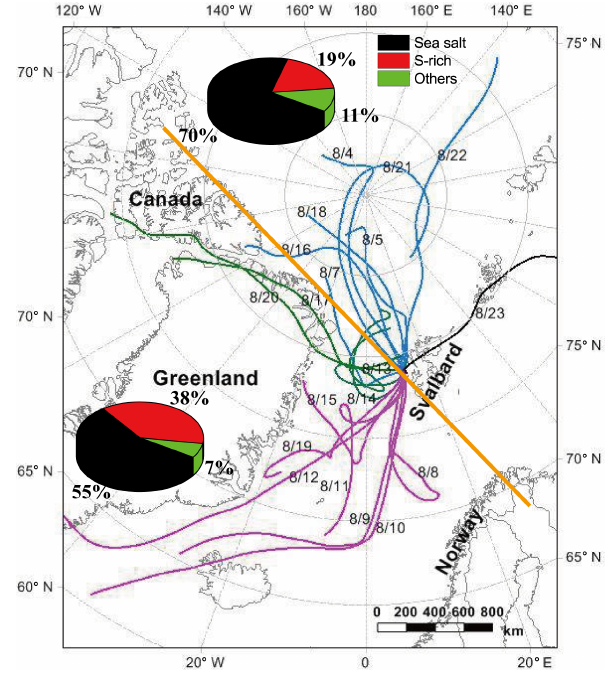
Figure 1. 72h back trajectories of air masses at 500m over Arctic Yellow River Station in Svalbard during 3–26 August 2012, and arriving time was set according to the sampling time. Air masses were divided into two groups by the yellow line: one group from the central Arctic Ocean and the other one from North America and Greenland. Pie charts show the number fractions of sea salt, S-rich, and other